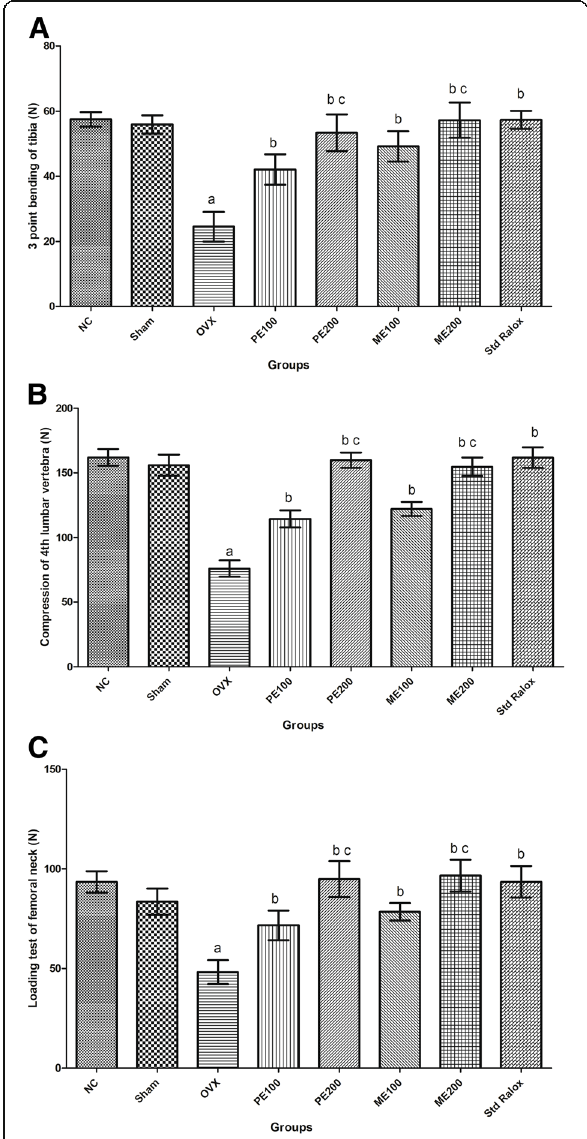
Fig. 6 Effect of plant extracts of B. ceiba on biomechanical parameters; ( a ) Three-point bending of the tibia, ( b ) Compression of the 4th lumbar vertebra, ( c ) Loading test of femoral